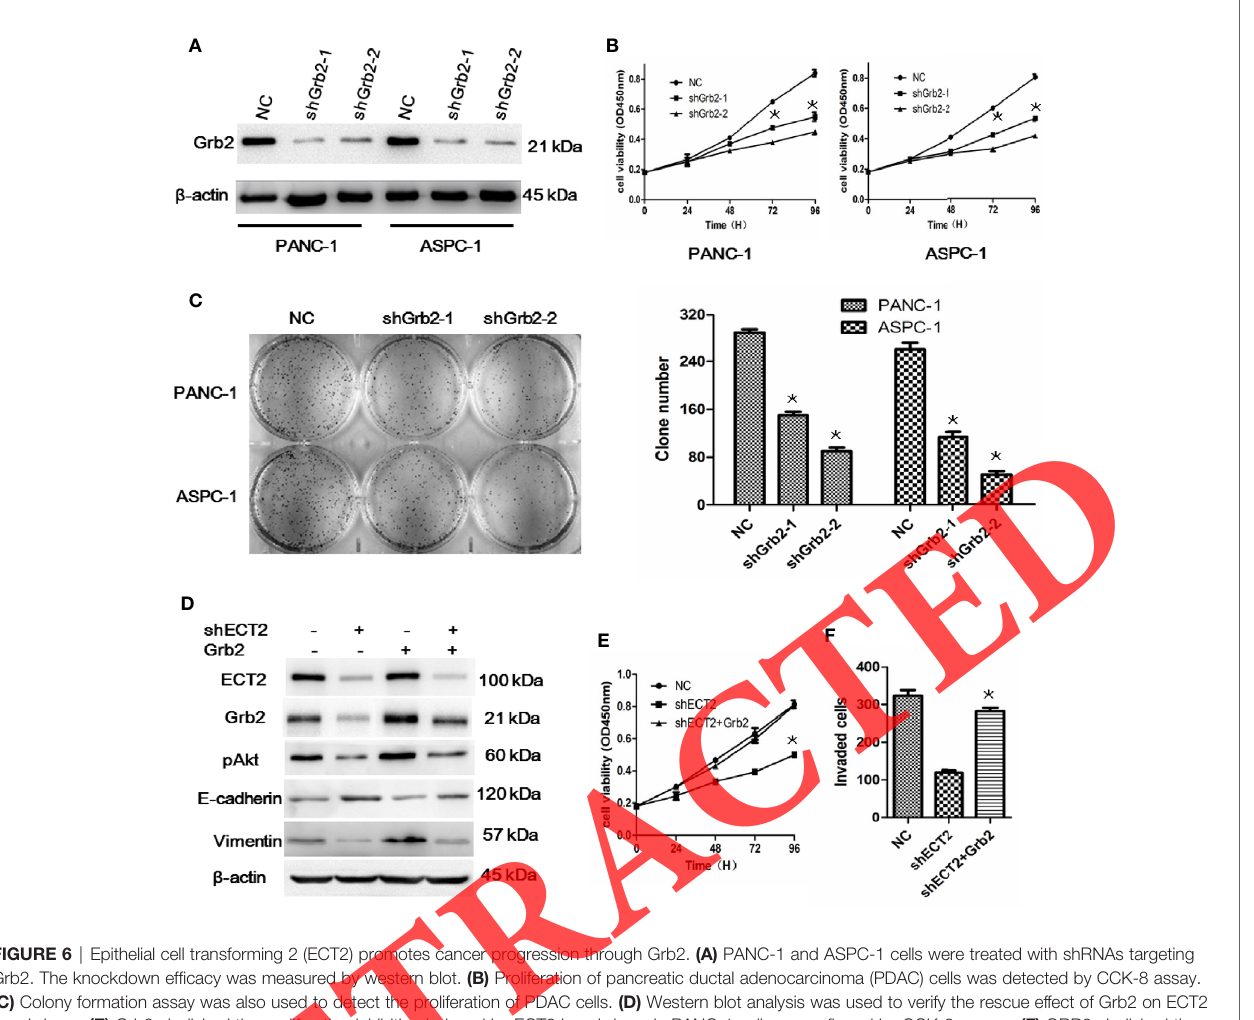
FIGURE 6 | Epithelial cell transforming 2 (ECT2) promotes cancer progression through Grb2. (A) PANC-1 and ASPC-1 cells were treated with shRNAs targeting Grb2. The knockdown ef fi cacy was measured by western blot. (B) Proliferation of pancreatic ductal adenocarcinoma (PDAC) cells was detected by CCK-8 assay. (C) Colony formation assay was also used to detect the proliferation of PDAC cells. (D) Western blot analysis was used to verify the rescue effect of Grb2 on ECT2 knockdown. (E) Grb2 abolished the proliferation inhibition induced by ECT2 knockdown in PANC-1 cells as con fi rmed by CCK-8 assays. (F) GRB2 abolished the invasion inhibition induced by ECT2 knockdown in the PANC-1 cells as con fi rmed by the transwell assays. *p <